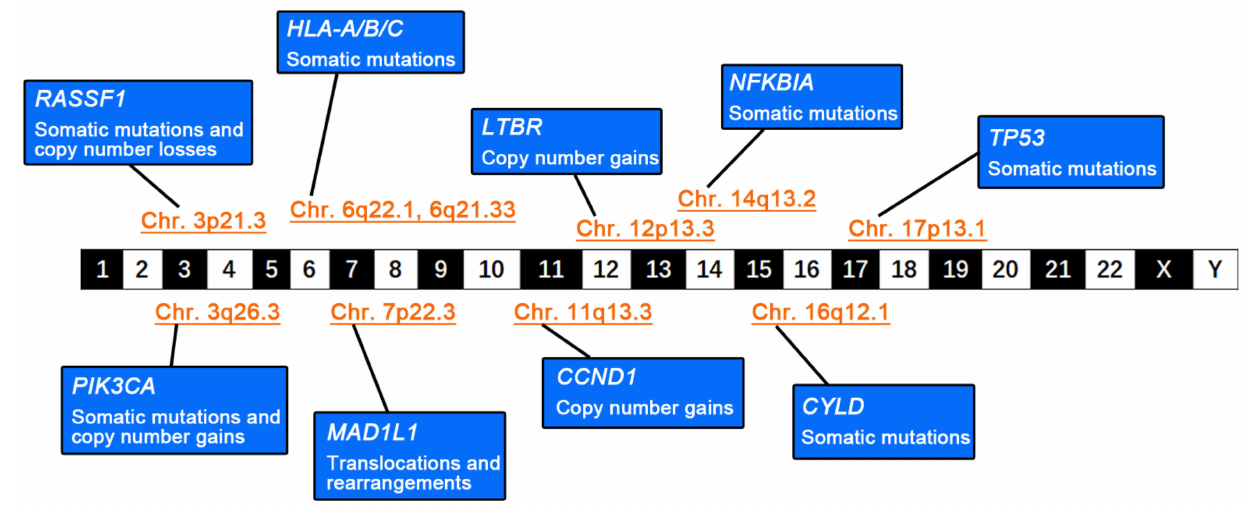
Figure 1. Genomic instability in nasopharyngeal carcinoma (NPC). The schematic diagram summa- rizes the genetic abnormalities and alterations in various tumor-associated functional genes and their locations on the